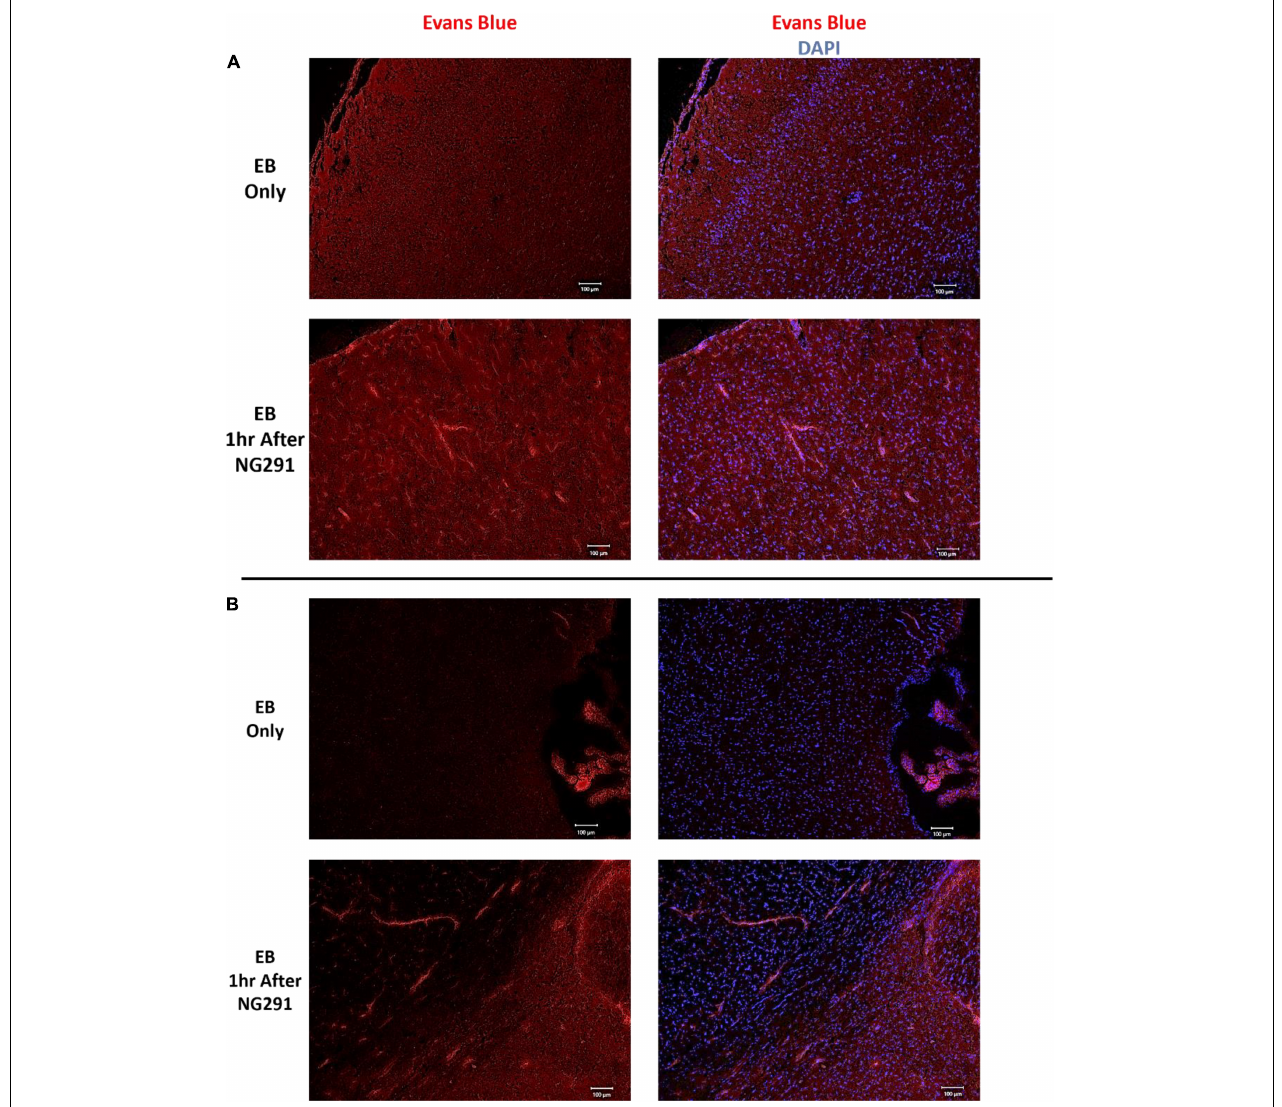
FIGURE 1 | Evans blue extravasation following NG291. Sprague Dawley rats were administered 100 µ g/kg of NG291 (i.v.) or saline (i.v.). Saline or NG291 was allowed to circulate for 1 h prior to Evans blue (EB, 4 ml/kg) administration. EB circulated overnight, and then the brains were harvested and coronally sectioned 20 µ m thickness in a microtome. Brain sections were mounted onto slides and stained with DAPI prior to mounting onto coverslips. Evans blue extravasation was detected via fluorescence (excitation at 620 nm, emission at 680 nm) using a Keyence BZ-800 fluorescent microscope. Panel (A) includes images taken of the cortex, panel (B) contains images taken of brain regions adjacent to the lateral ventricles. Scale bar: 100 µ m in length.